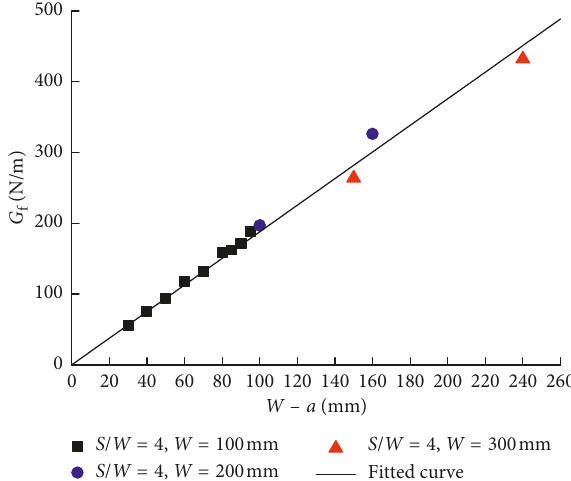
Figure 3: Fracture energy G ligament